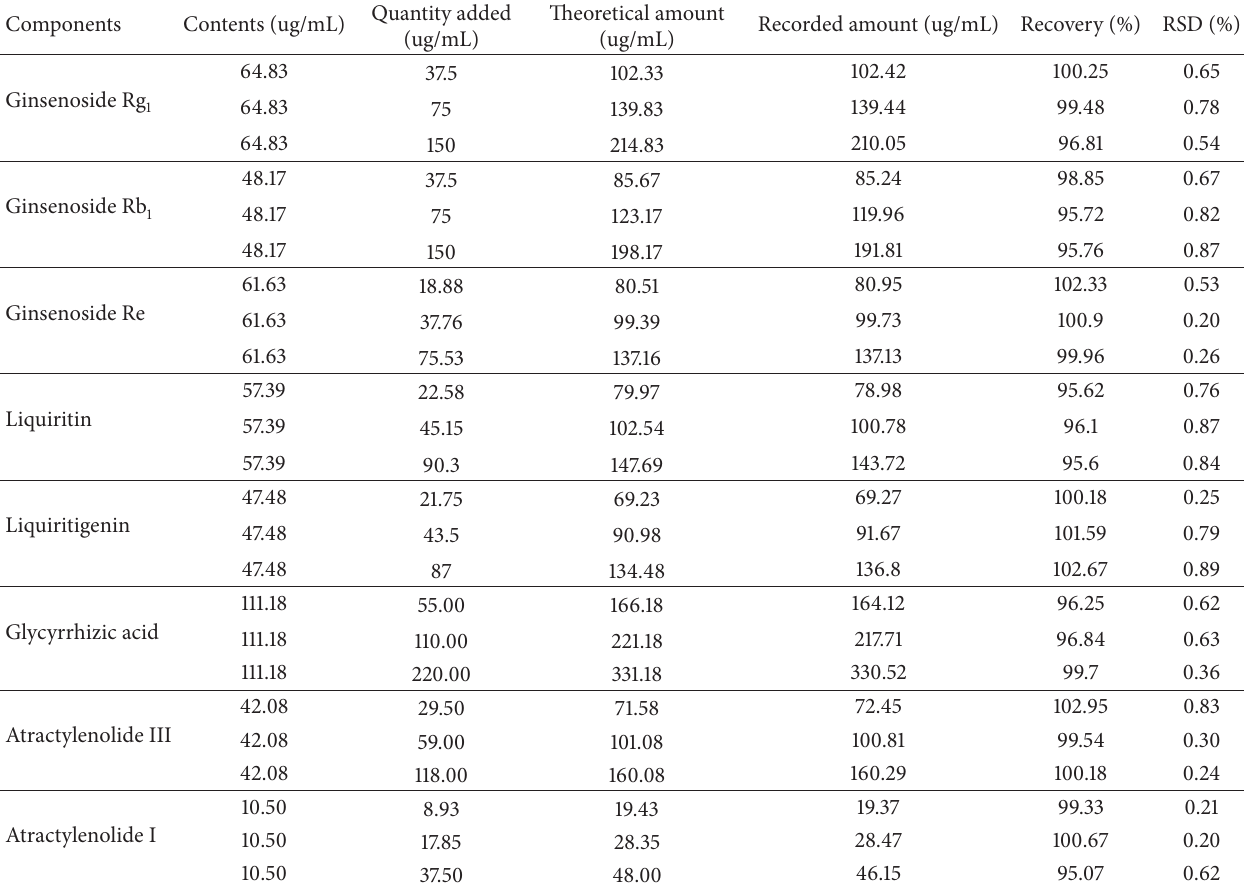
Table 3: Recovery of eight components in Sijunzi ( 𝑛 = 3